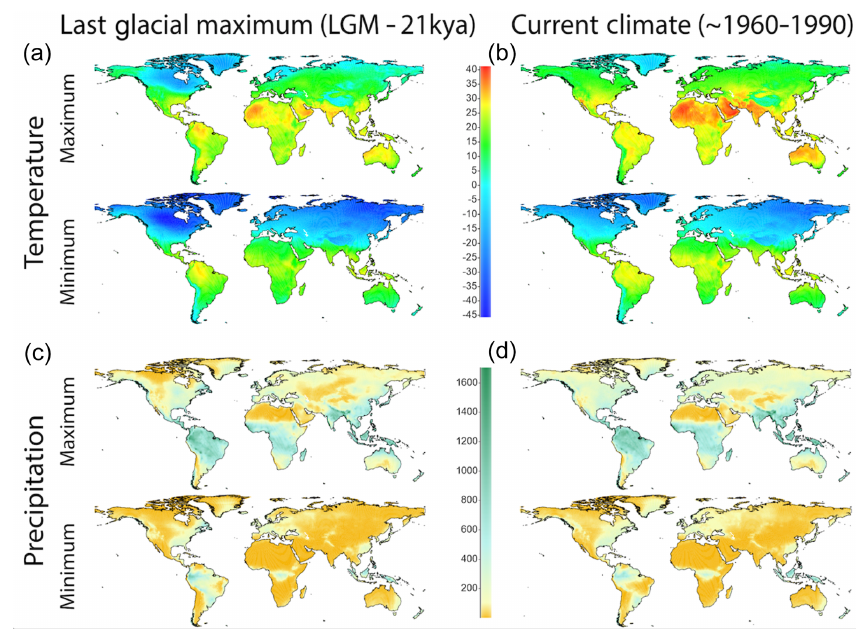
Figure 9. Downscaled emulated climate. Panels (a) and (c) are the downscaled emulated bioclimatic variables at the Last Glacial Maximum. Panels (b) and (d) are the present-day climatology (Hijmans et al., 2005). Note that downscaled climates are derived by applying emulated anomalies to this present-day climatology. An animation of the complete 5Ma reconstruction is provided as